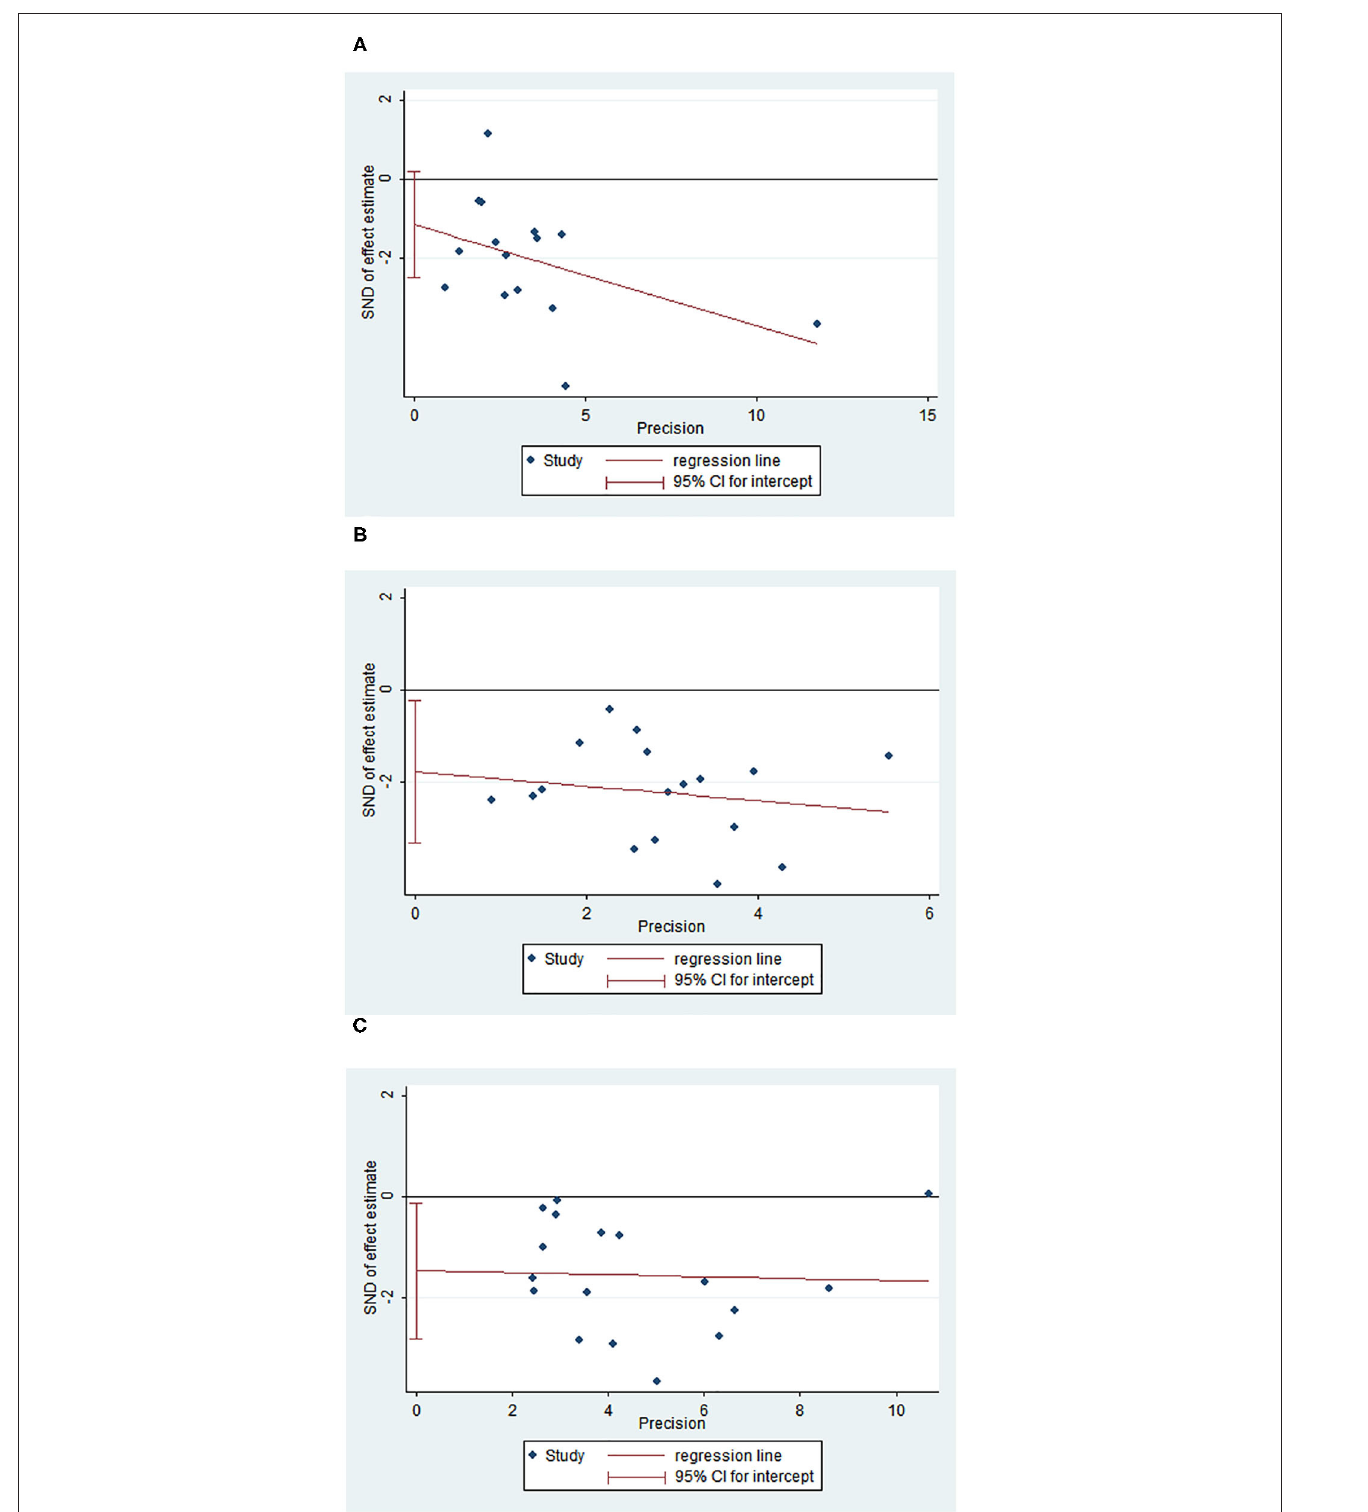
FIGURE 6 | Funnel plot of OS, 3- and 5-year survival outcomes. (A) Egger plot for 3-year survival rates; (B) Egger plot for 5-year survival rates; (C) Egger plot for OS.